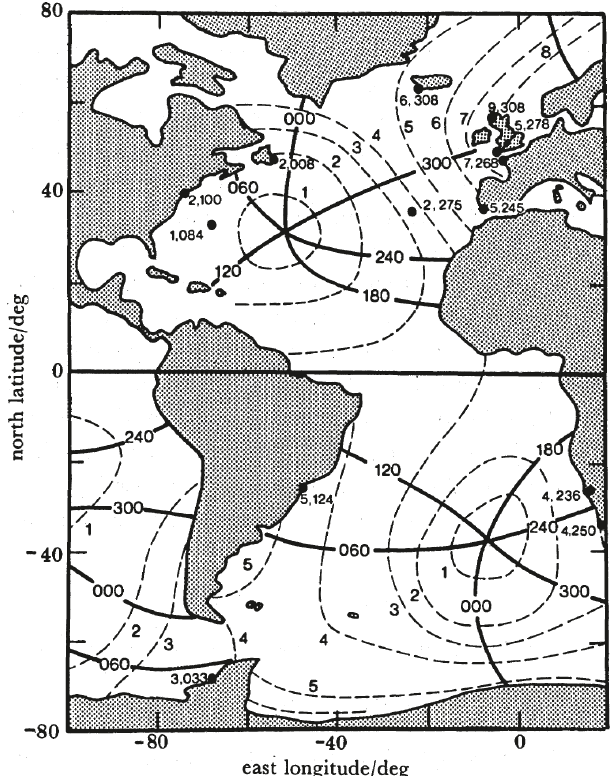
Figure 1. Contours of equal amplitude (millimetres, dashed lines), and equal phase lag (degrees, full lines) synthesized for the com- ponent M1, transposed from Fig. 9 of Platzman (1984b) with 60 ◦ arbitrarily added to phase values. Black circles are positions of mul- tiyear coastal stations at which M1 has been directly evaluated, with amplitude and phase lag shown alongside each station loca- tion. From Cartwright et al. (1988).